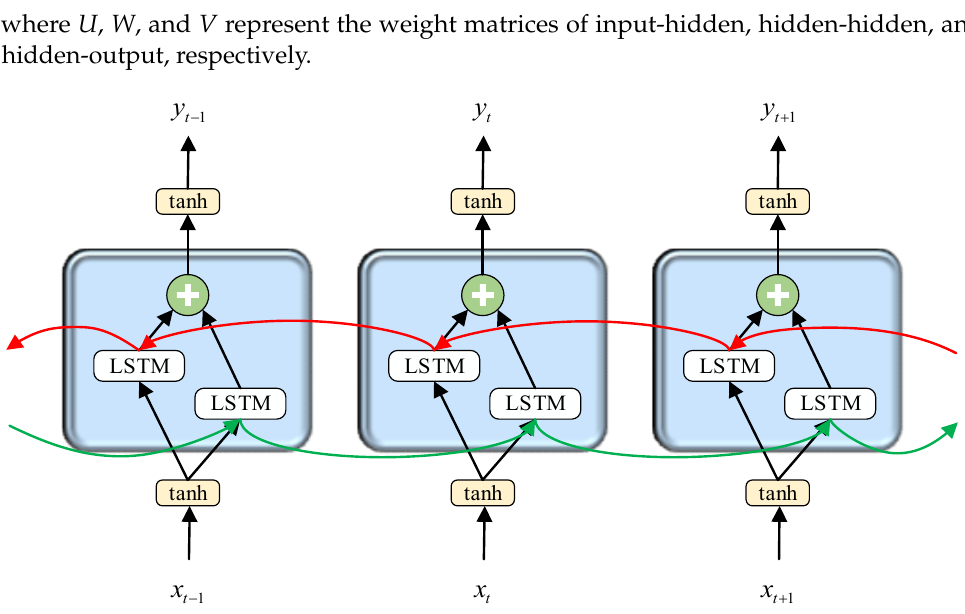
Figure 7. Schematic diagram of bidirectional LSTM network.